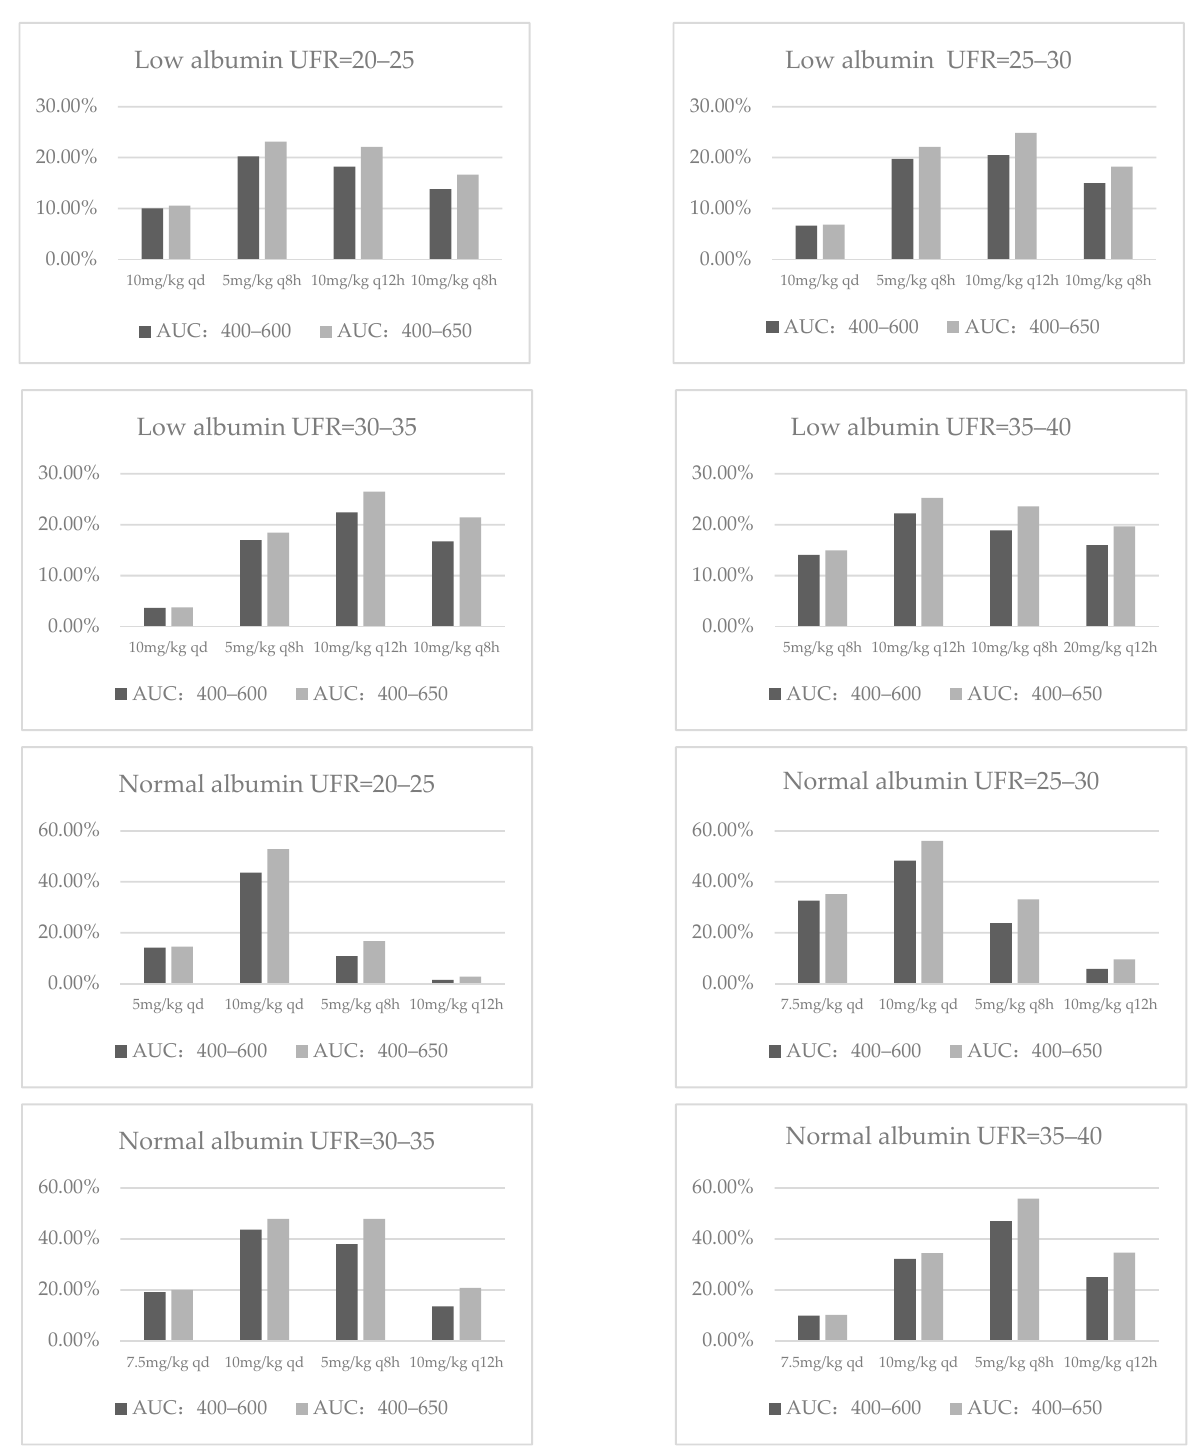
Figure 3. PTA for different dosage regimens in each subgroup.